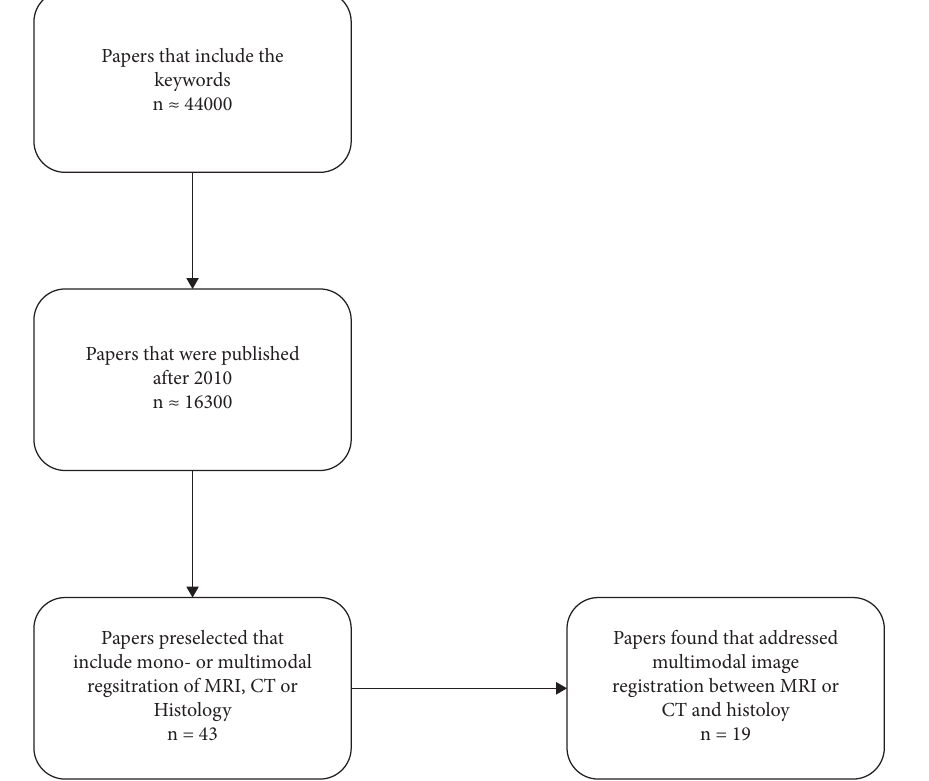
Figure 2: Visualization of the process behind the inclusion of the selected literature. Starting with over 44000 initial hits for the stated search terms, 16300 were published after 2010 and considered for further investigation. From this group, we identifed 43 papers concerning image registration in the context of CT, MRI, and histology. From this group, we further extracted 19 that addressed multimodal registration.